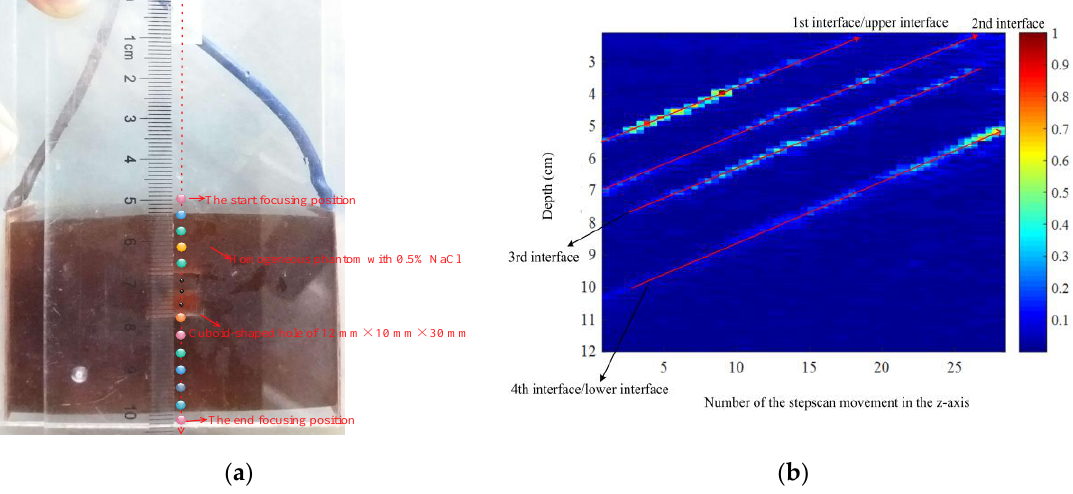
Figure 4. The influence of single focus on the experiment: ( a ) the movement track of the focal point position, which passed through a cuboid-shaped hole; and ( b ) the brightness curves with the interface information.